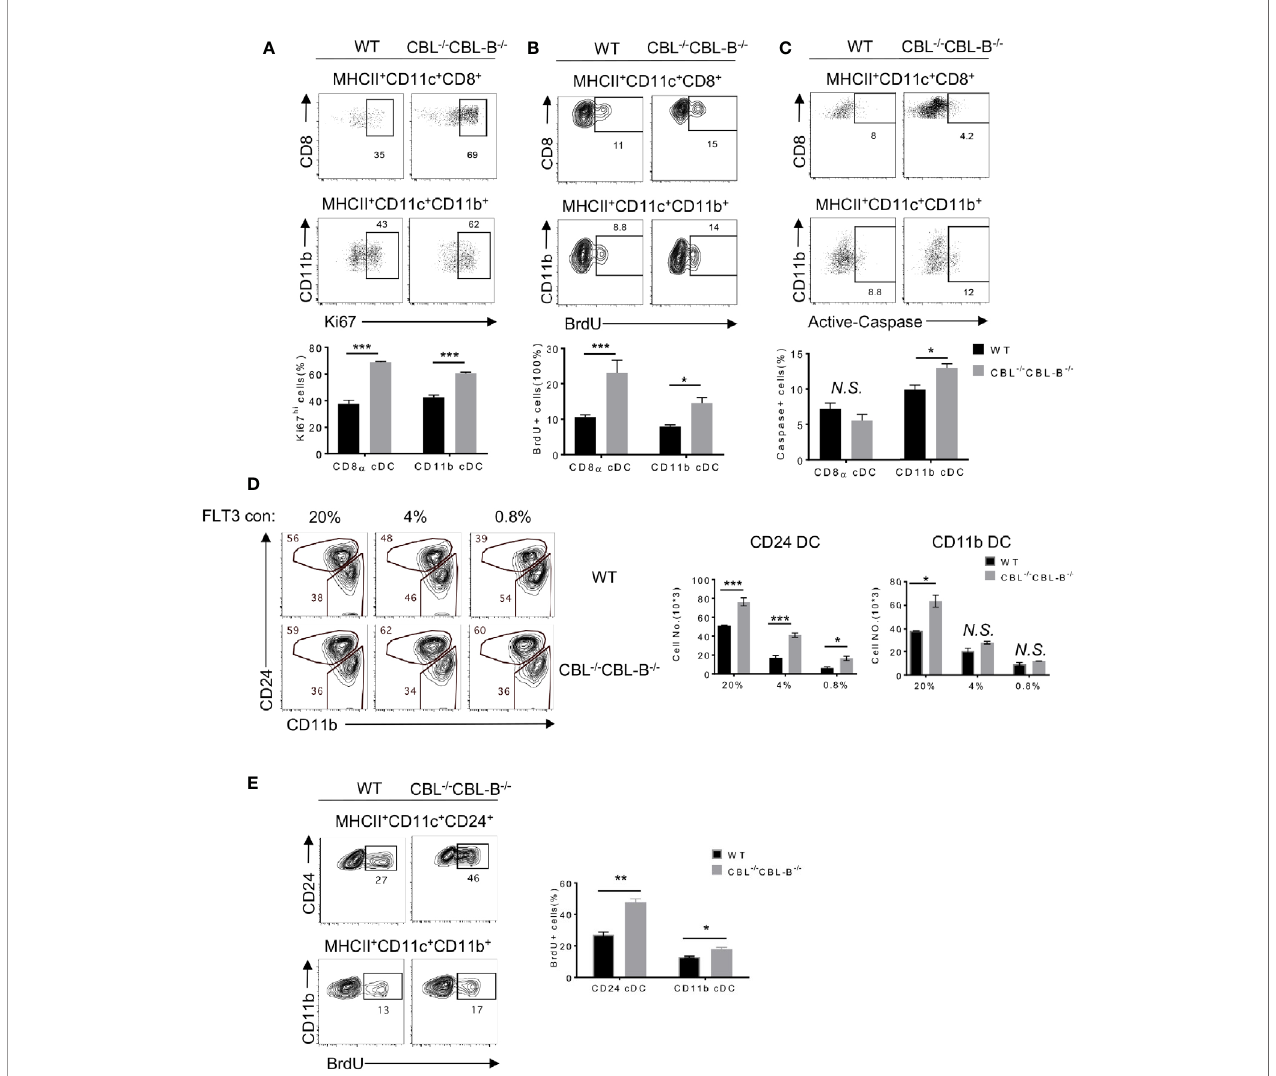
FIGURE 2 | Proliferation, death, and lineage commitment of WT and CBL -/- CBL-B -/- cDCs. (A – C) Flow cytometry (top panels) and statistics (bottom panels) of splenic proliferating (A, B) and apoptotic (C) CD8 a + cDC1s and CD11b + cDC2s, as determined respectively by anti-Ki67 (n = 3) (A) , BrdU (n = 6) (B) , and anti- Active Caspase (n = 3) (C) staining. (D) Comparison of WT and CBL -/- CBL-B -/- CD24 + (CD8 a + -like) cDC1s and CD11b + cDC2s in FLT3 dependent BM cell culture. Shown are the contour maps (left) and statistics (right) of CD24 vs CD11b staining of the gated CD11c + cells (n = 3). (E) Proliferation of WT and CBL -/- CBL-B -/- cDC generated in FLT3 dependent BM cell culture. Shown are FACS analyses (left) and statistics (right) of BrdU + CD24 hi CD11b lo and CD24 lo CD11b hi cells (n = 3). Data are mean ± SEM. of at least two independent experiments. N.S., not signi fi cant; *p < 0.05; **p < 0.01; ***p <